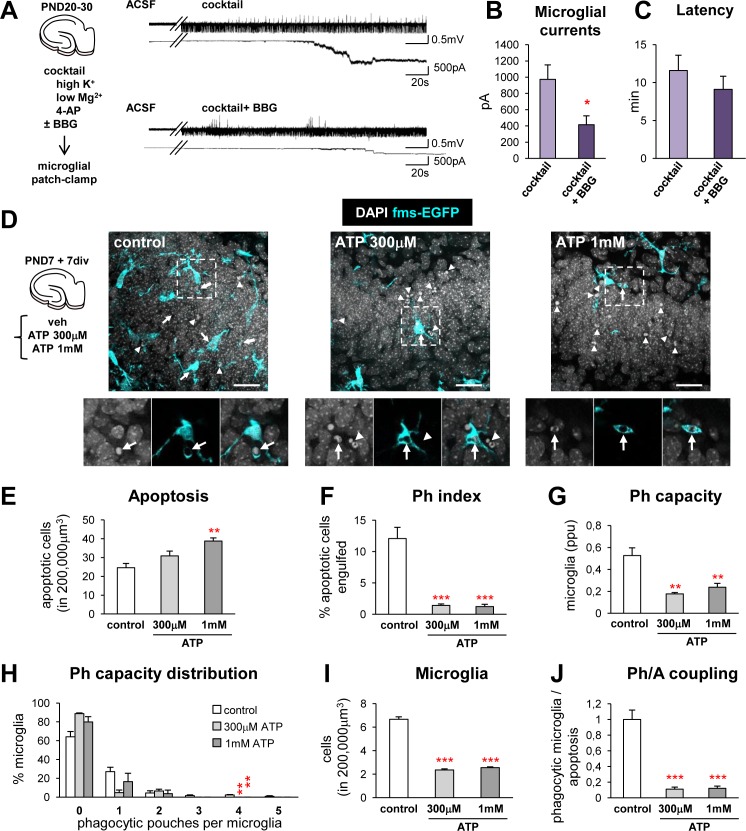
Seizures trigger ATP-mediated microglial activation and impairment of phagocytosis.(A) Experimental design used to induce seizures in acute hippocampal slices with an epileptogenic cocktail that included high K+, low Mg2+, and 4-AP in ACSF, in the presence or absence of the broad P2X receptor antagonist BBG (5 μM). Seizure activity was recorded in CA1, where it had higher amplitude than in the DG. Top, extracellular recording (mV) and bottom, simultaneous microglia patch clamp recording (pA) before and after seizure induction in the absence or presence of BBG. BBG did not alter seizure frequency or amplitude (S10K–S10M Fig). (B) Patch-clamp currents (in pA) induced in microglia by the seizure activity after the epileptogenic cocktail in the absence (control, n = 18 cells) or presence of the P2X antagonist BBG (n = 11 cells). (C) Latency (in minutes) of the currents induced in microglia by the seizure activity. (D) Experimental design and representative projections of confocal z-stacks of fms-EGFP organotypic slices treated with vehicle (control) or ATP (300 μM and 1 mM) for 4 h. Normal or apoptotic nuclear (pyknotic/karyorrhectic) morphology was visualized with DAPI (white) and microglia by the transgenic expression of fms-EGFP (cyan). The high magnification inserts show single images of apoptotic cells phagocytosed by microglia (arrows) or not phagocytosed (arrowheads). (E) Number of apoptotic cells in a 200.000 μm3 volume containing the DG in organotypic slices treated with ATP (n = 3 slices per group). (F) Ph index in organotypic slices (in %). (G) Weighted Ph capacity (in ppu) in organotypic slices. (H) Histogram showing the Ph capacity of microglia distribution (in % of cells) in organotypic slices treated with ATP. (I) Number of microglia in organotypic slices. (J) Ph/A coupling (in fold-change) in organotypic slices. Bars represent mean ± SEM. * indicates p < 0.05, ** indicates p < 0.01, and *** indicates p < 0.001 by Student´s t test (B) or by Holm-Sidak posthoc test after one-way ANOVA (E–J) was significant at p < 0.05. Scale bars = 30 μm. z = 6.3 μm. Underlying data is shown in S1 Data.